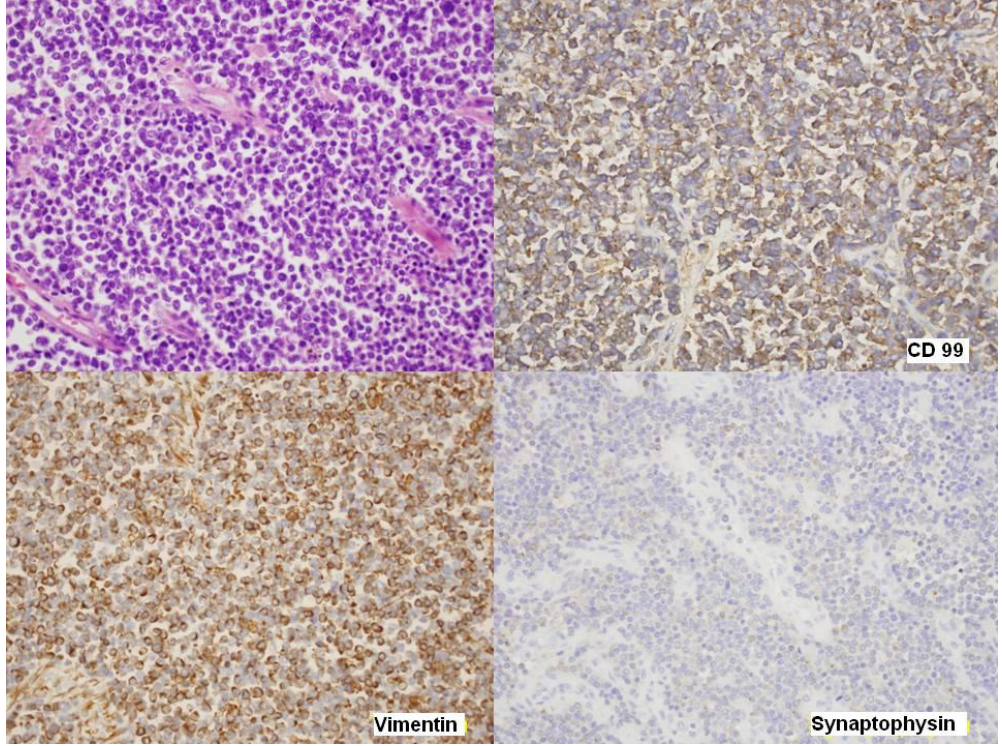
FIGURE 4. Immunohistochemical staining showing strong expression of CD99 and vimentin, and weak expression of synaptophysin. Upper left quadrant is